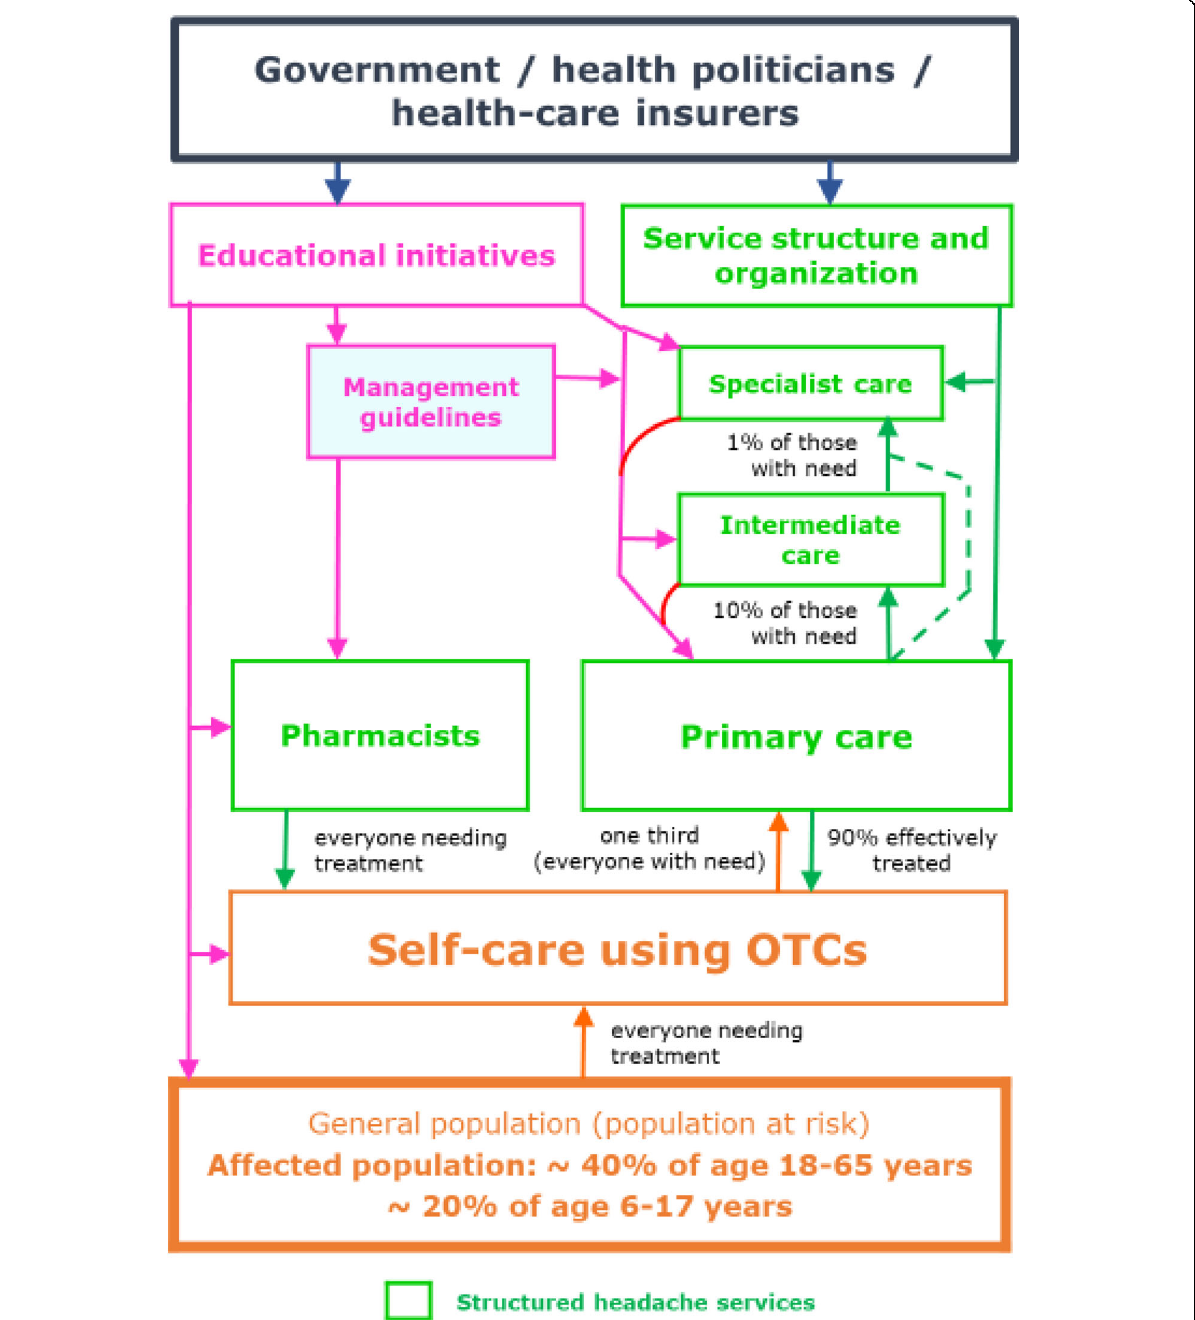
Fig. 1 Template for structured headache services supported by educational initiatives, and expected patient flows (as described in [9]: structured headache services are based in primary care and supported by specialist care; educational initiatives are aimed at health-care providers to improve competence at their level, and at the public to promote self-care and effective use of both over-the-counter (OTC) drugs and headache services; pharmacists advise on use of OTC and other drugs, discouraging overuse, and on use of headache services; within these services, everyone with headache should make best use of OTC drugs; about one third of people with headache need professional health care; primary care provides effective management for most of these, while specialist care is reserved for the small proportion who need